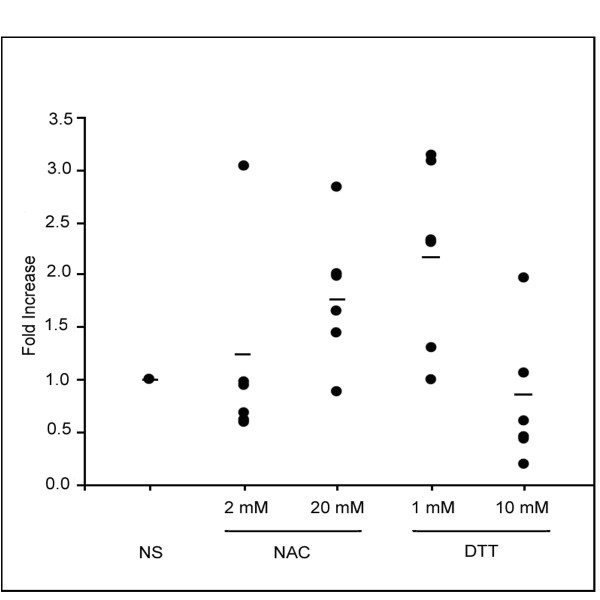
NAC and DTT do not consistently reduce TGF-β mRNA synthesis from human monocytes. Monocytes (10 × 106 per condition) were treated with 2 mM NAC, 20 mM NAC, 1 mM DTT, or 10 mM DTT and incubated for 24 hours. Data points represent fold induction over non-stimulated; mean is represented by horizontal bar. Only DTT 10 mM reduced TGF-β mRNA versus non-stimulated control cells (p < 0.05) other conditions were not significantly different statistically. This data represents three independent studies.